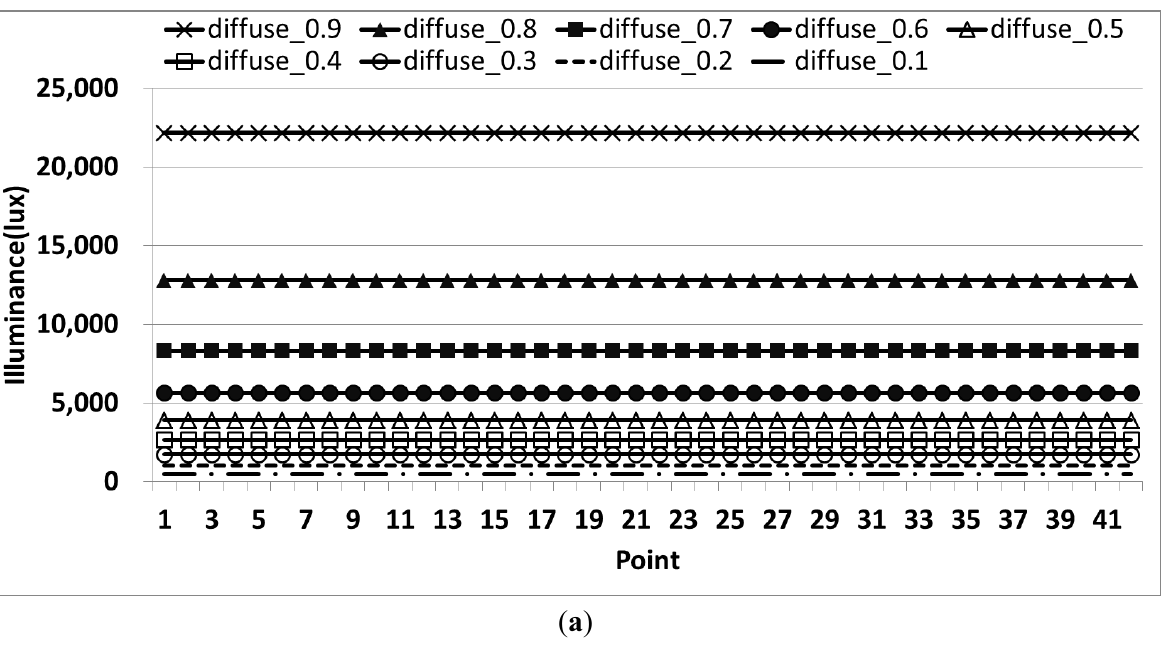
Figure 10. Winter solstice condition shows Illuminance level due to diffuse light [21]: ( a ) illuminance level due to diffuse light in the Split-flux method [21]; ( b ) illuminance level due to diffuse light in the Radiosity method